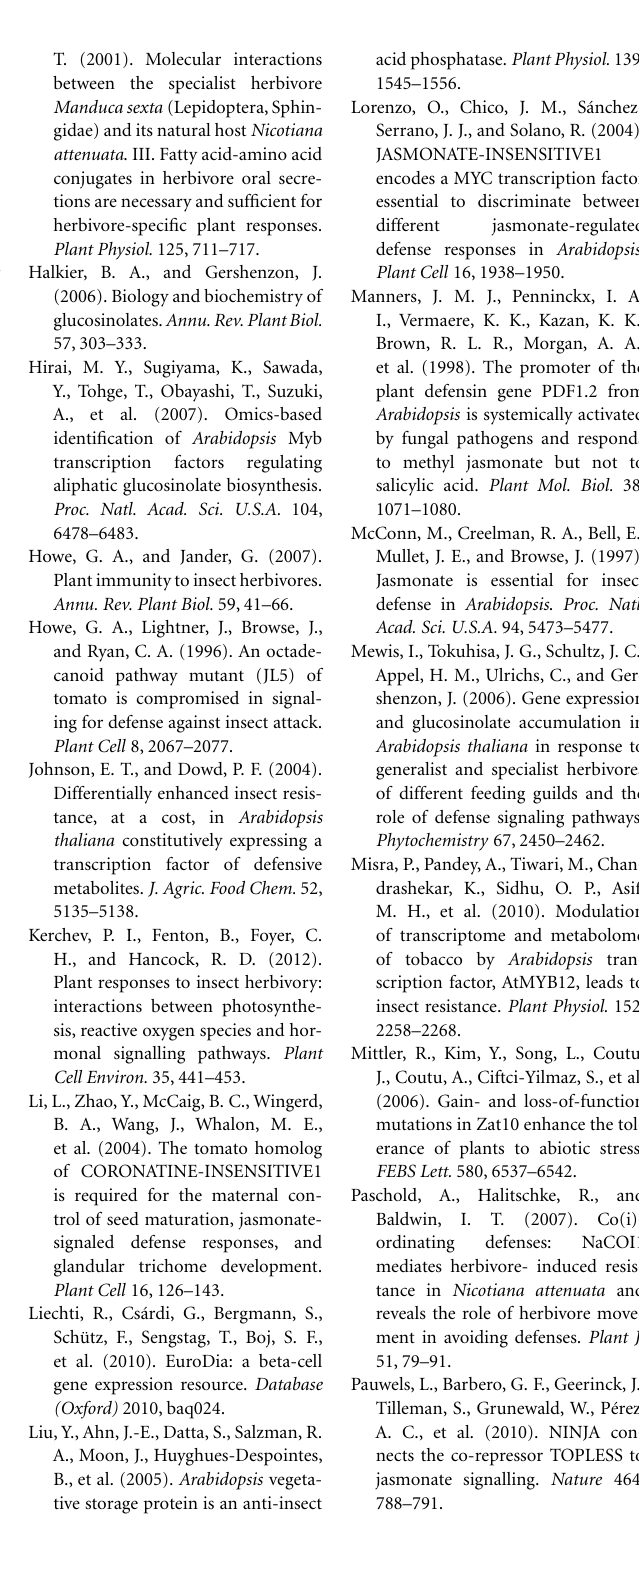
Table S1 | List of insect-inducedTFs. Table S2 |Whole-genome expression data for Col-0 andTF mutants. Table S3 | List of primers used in this